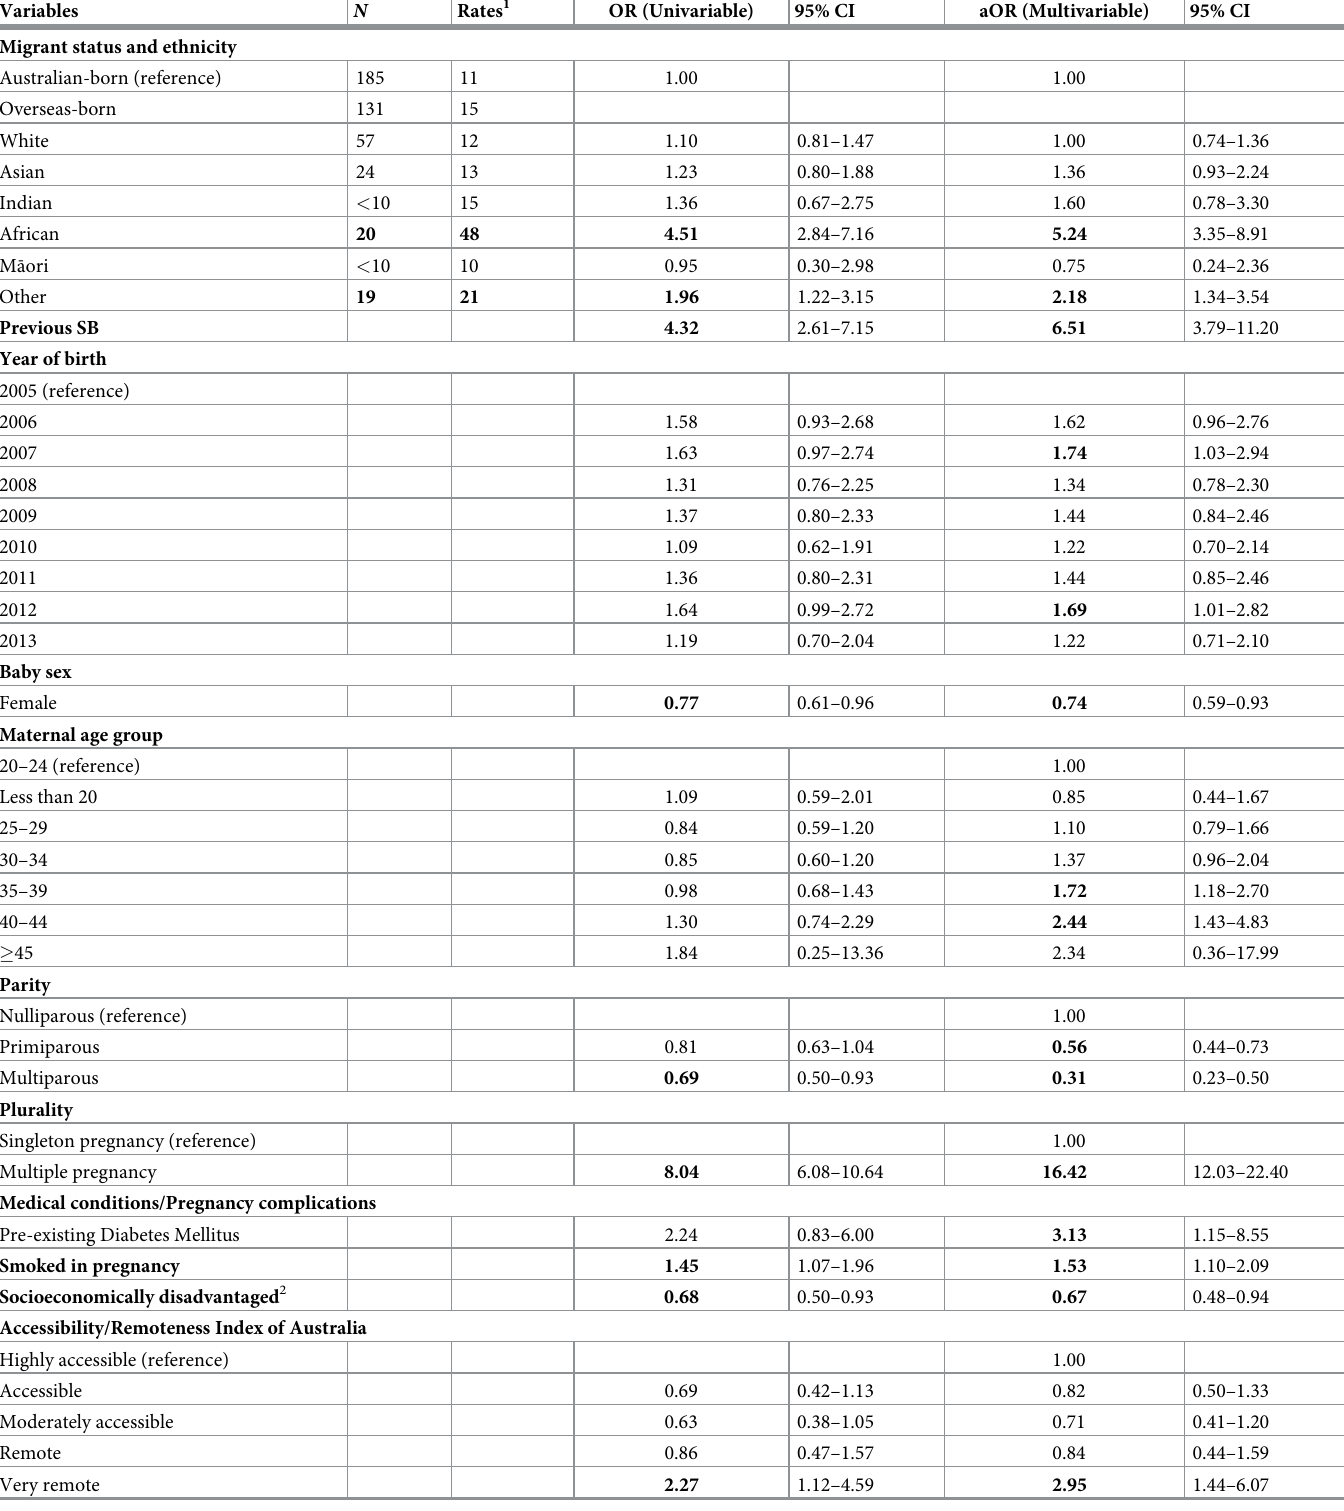
Table 4. Logistic regression model and the factors associated with IntraSB